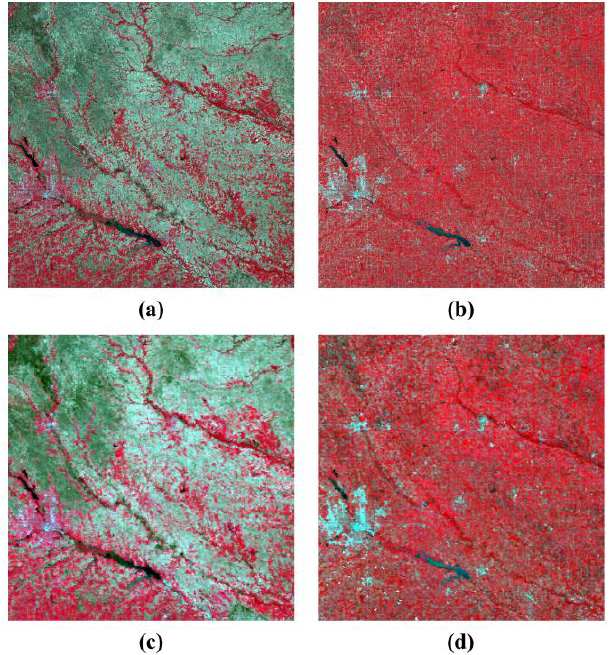
Figure 4. Dataset of the central Iowa (CI) site. ( a ) Landsat image, 14 May 2002; ( b ) Landsat image, 2 July 2002; ( c ) MODIS image, 14 May 2002; ( d ) MODIS image, 2 July 2002.